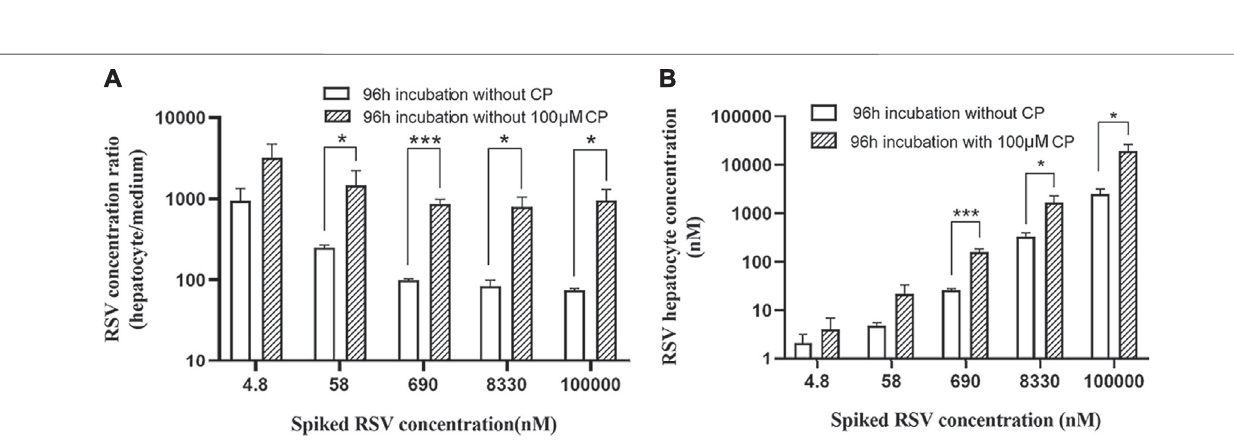
Frontiers in Pharmacology |